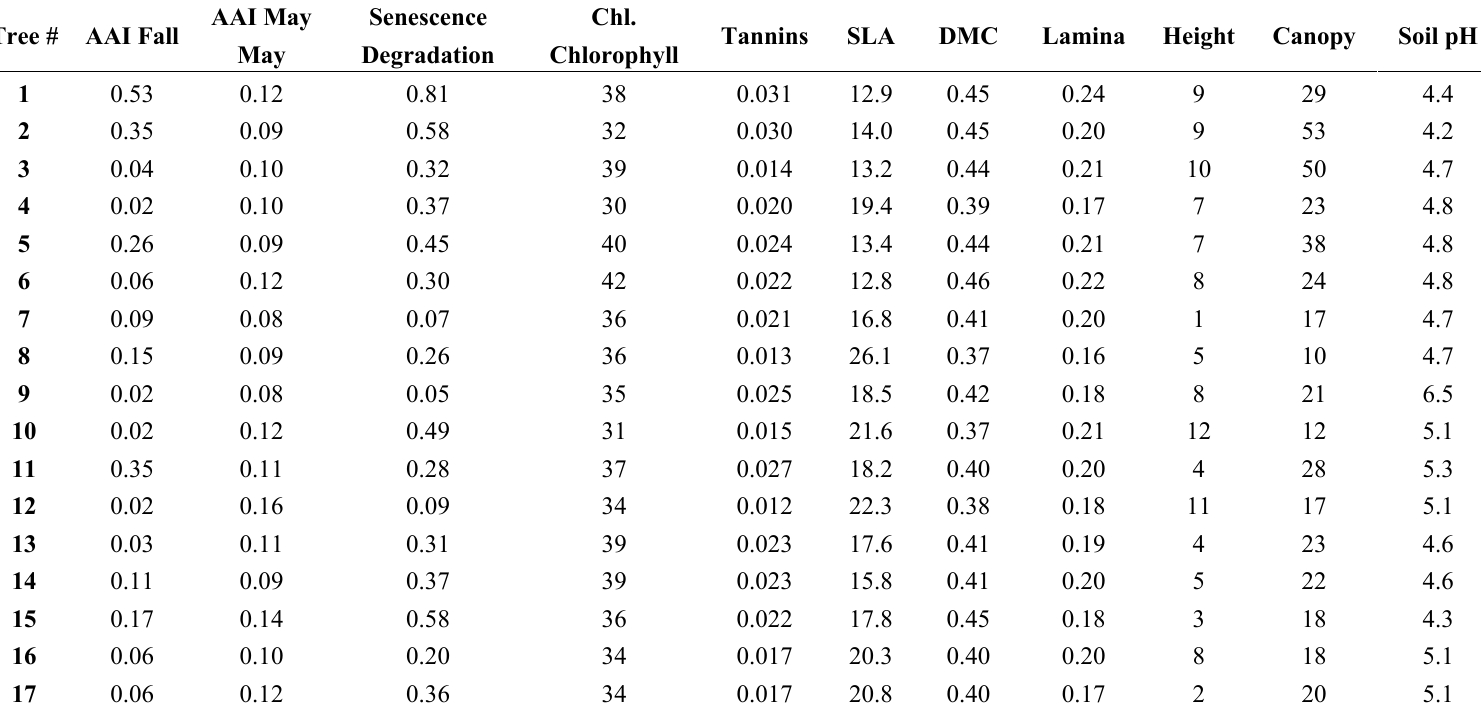
Table A1. The measured traits and environmental variables for the 27 red maple trees: Anthocyanin Absorbtion Index in autumn (AAI Autumn [24]); AAI in May; Proportion of chlorophyll degraded by mid-late September (Senescence; SPAD·SPAD −1 ); Leaf chlorophyll content in summer (Chl.; SPAD units); Tannins (g·g −1 Fresh mass ); Specific Leaf Area (SLA; m 2 ·g −1 ); Leaf dry matter content (DMC; g·g −1 ); leaf lamina thickness (Lamina; mm), canopy openness (%), soil